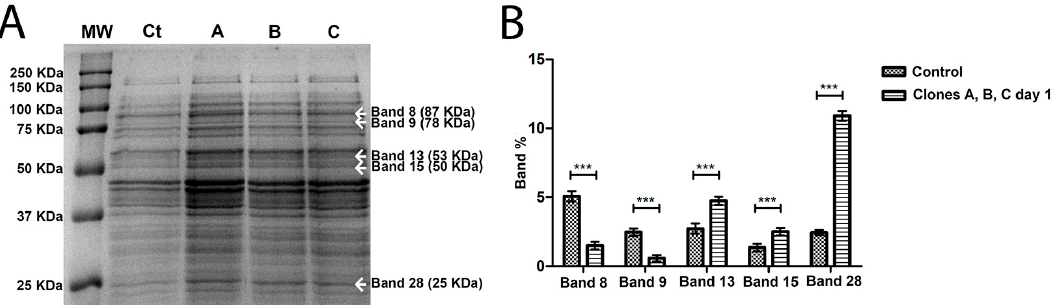
Figure 4. ( A ) SDS PAGE gel of the intracellular proteins of A. salmonicida on first streak-plating. MW, molecular weight marker; Ct, control phage-sensitive A. salmonicida ; A is Colony A of the phage-resistant A. salmonicida mutant; B is Colony B of the phage-resistant A. salmonicida mutant; C is Colony C of the phage-resistant A. salmonicida mutant. The marked bands are the ones that showed differential expression between control and clones A, B and C. Band weight is expressed in kilodalton (KDa). ( B ) Differential expression of the bands, in percentage, comparing Control ( phage-sensitive A. salmonicida ) with clones A, B and C (phage-resistant A. salmonicida ) after 1 streak-plating steps. *** p < 0.001.